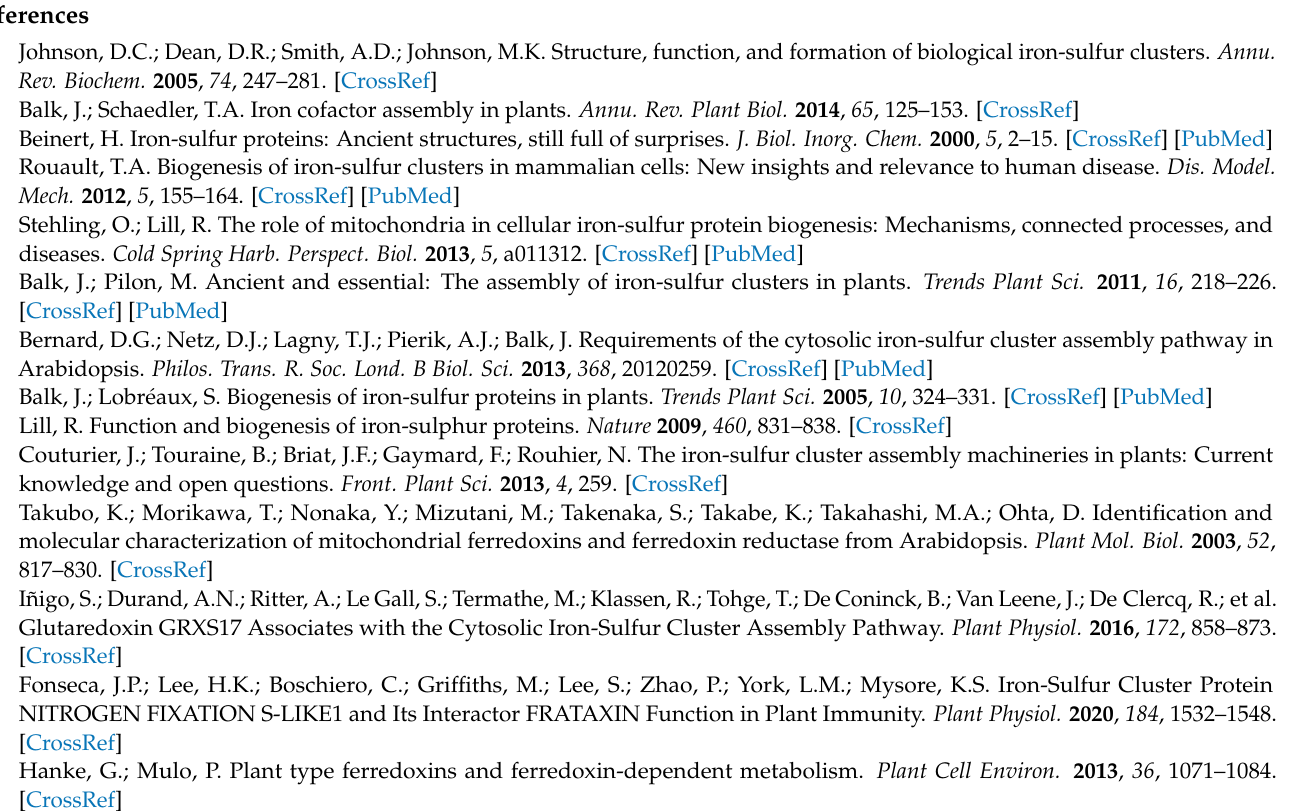
the nonhost pathogen P. syringae pv. tomato T1 than the control., Figure S2: The mfdx1 and mfdx-2 mutants have completely abolished or reduced MFDX1 expression, respectively compared to the WT. Figure S3: Expression of AtMFDX1 in different organs in Arabidopsis. Figure S4: Comparison of nutrient accumulation between the mfdx1-1 mutant and WT plants upon P. syringae pv. tomato DC3000 infection. Table S1: GC/MS primary metabolite data in the NFS1.2-18-OX line, mfdx1-1 mutant and the WT at 0 h, 1 d and 3 days upon host pathogen infection., Table S2: LC/MS data secondary metabolites in the NFS1.2-18-OX line, mfdx1-1 mutant and the WT at 0h, 1d and 3 days after host pathogen infection., Table S3: All primers used in this